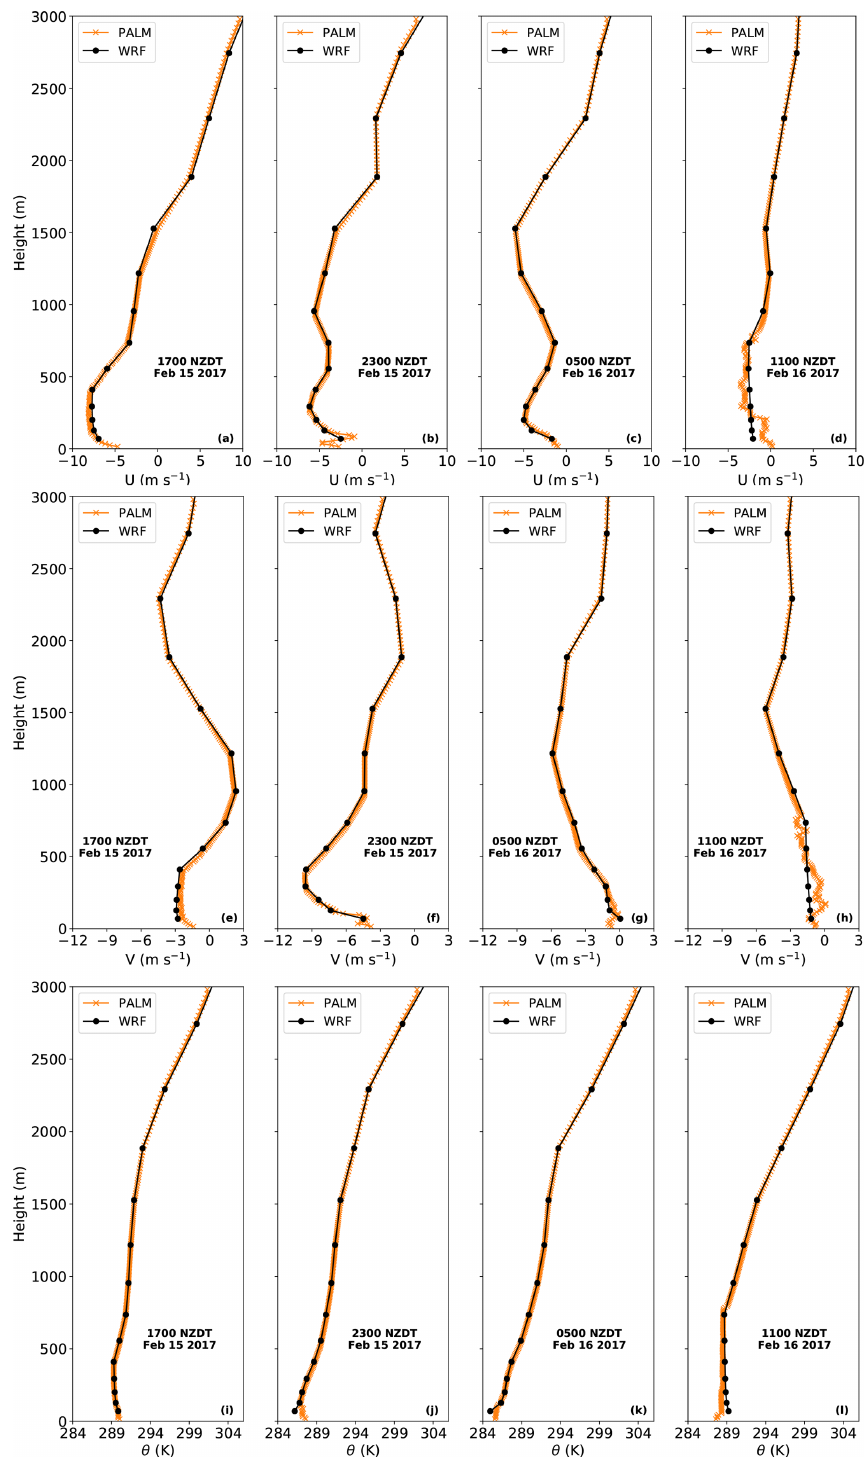
Figure 12. As in Fig. 6, but for the north-easterly case between 17:00NZDT, 15 May 2017 and 17:00NZDT, 16 May 2017.